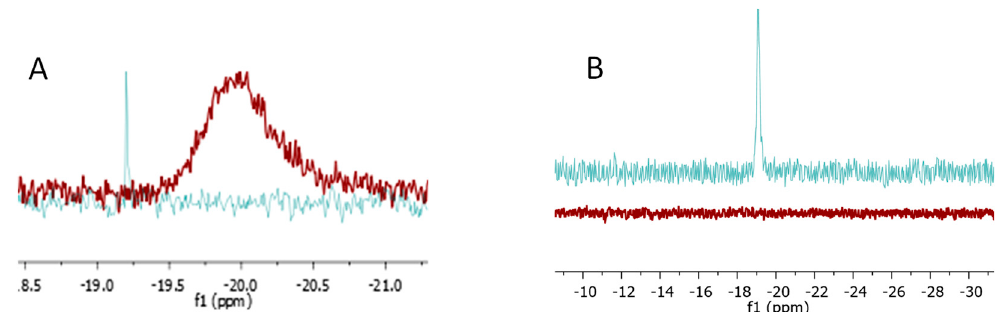
Figure 4. 31 P NMR spectra of nixantphos@CCM. ( A ) In THF- d 8 (brown trace), with the spectrum of the monomer 1 also shows in light blue for comparison; ( B ) in D 2 O before (brown trace) and after (blue trace) swelling with toluene.